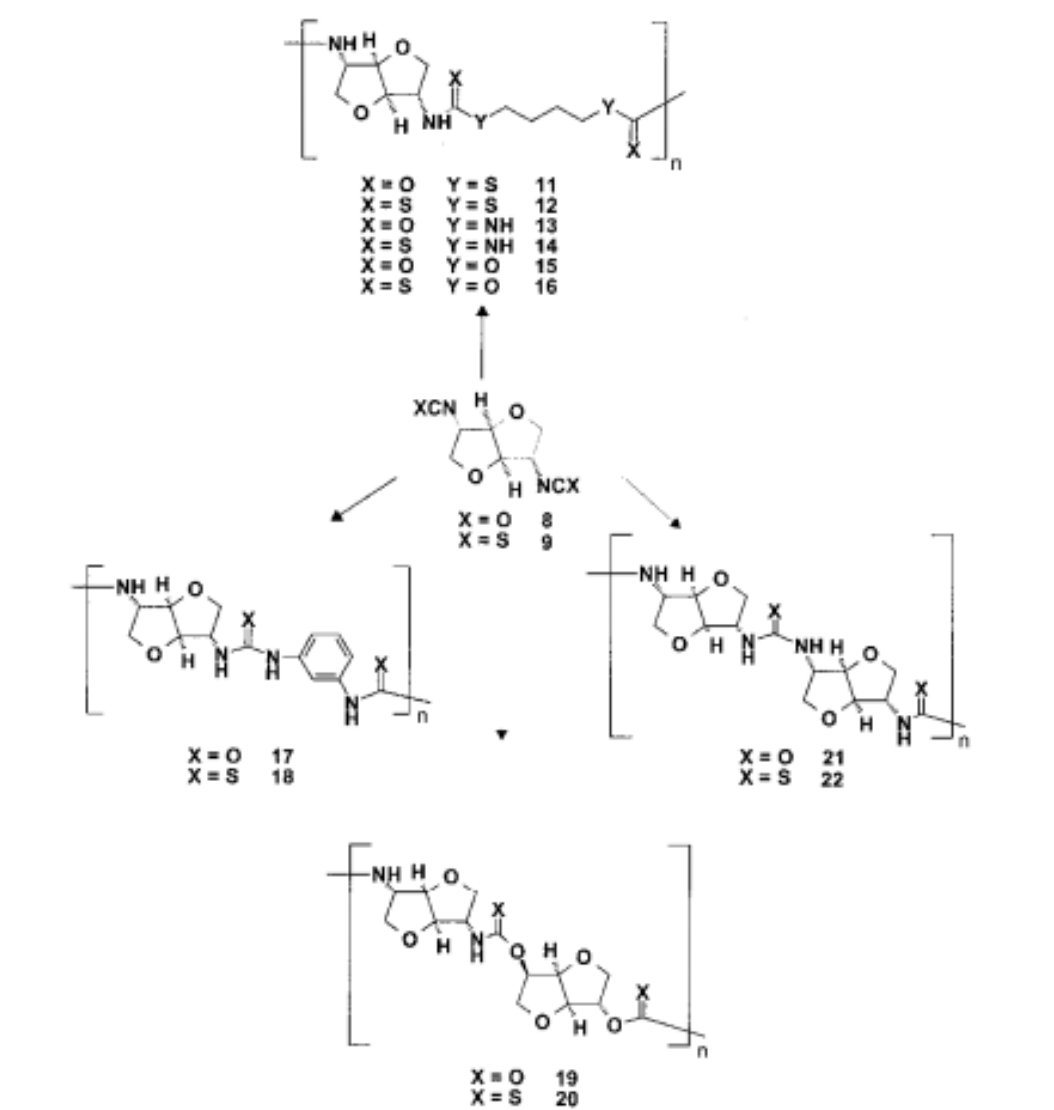
Figure 27. Synthesis of poly(thio)urethanes and poly(thio)ureas from the L-ido monomers 8 and 9. From reference [57].